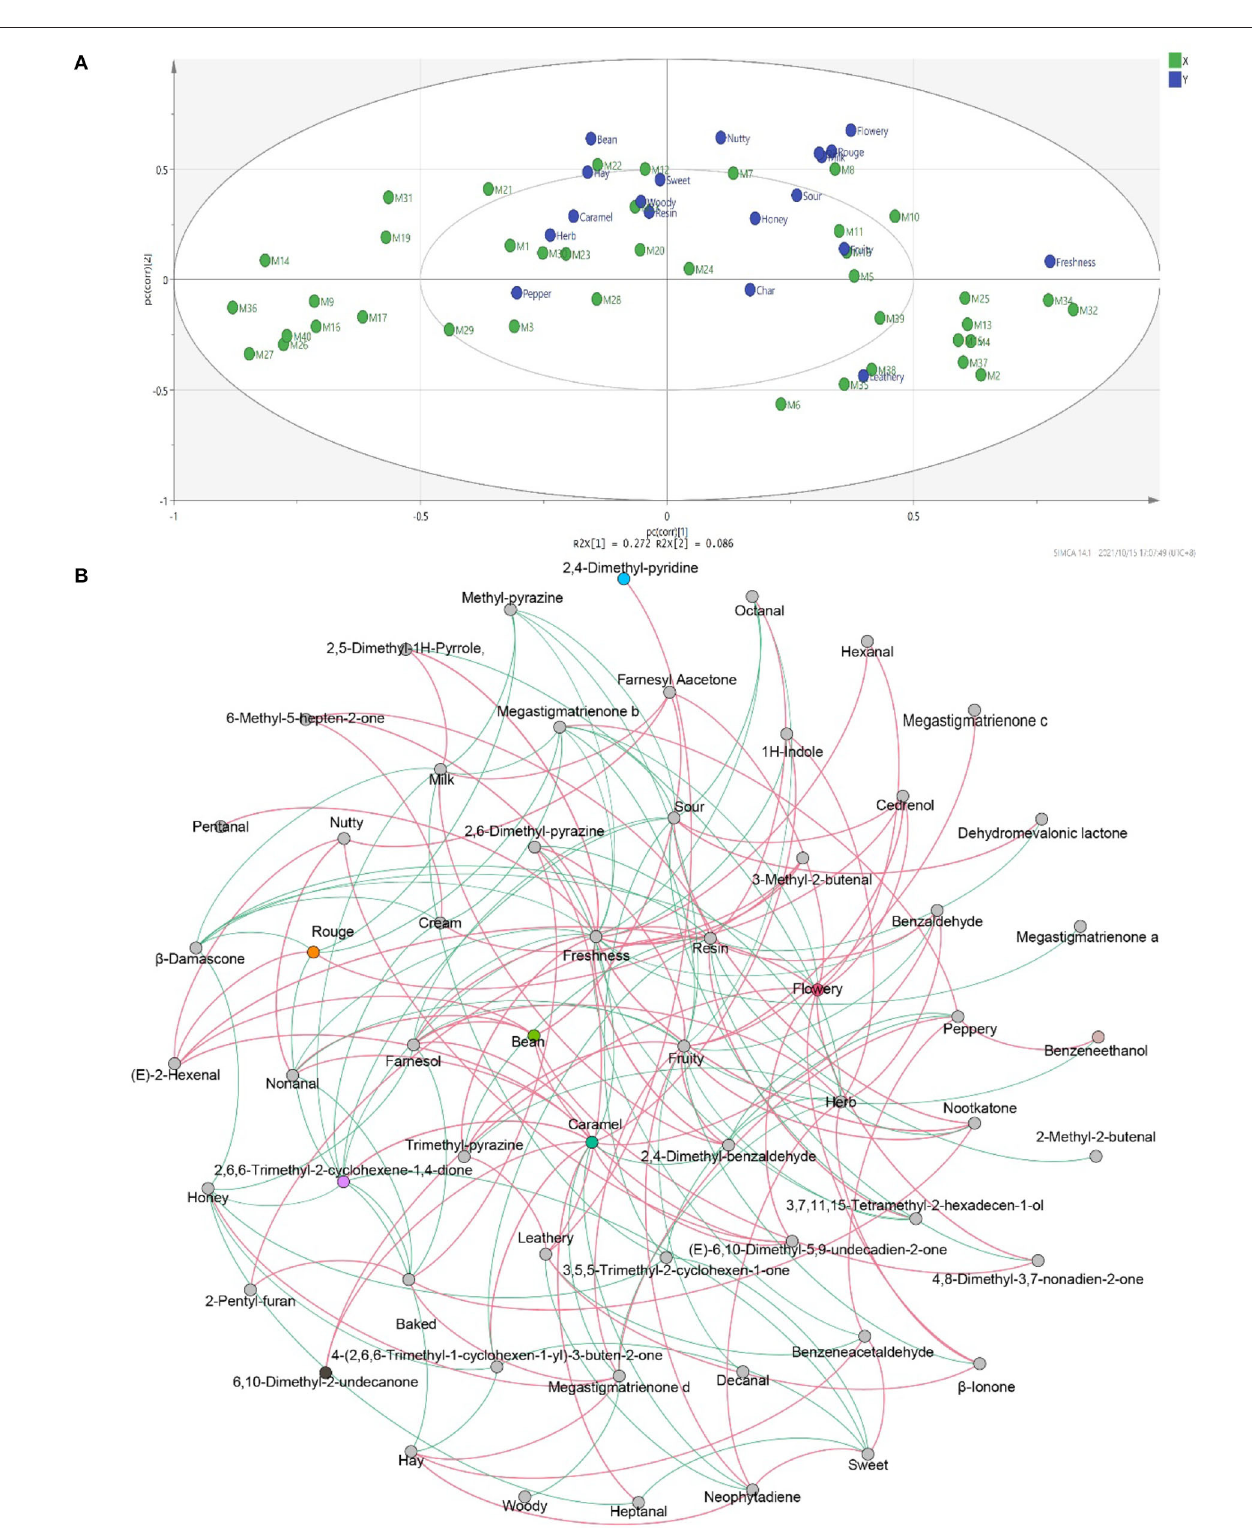
FIGURE 9 | The correlation between flavors and volatile flavor compounds. Correlation loadings plot of PLSR analysis between core volatile flavor compounds and flavors of CTLs (A) . Co-occurrence networks of flavors and core volatile flavor compounds. Green line means negative correlation; red line means positive correlation (B)